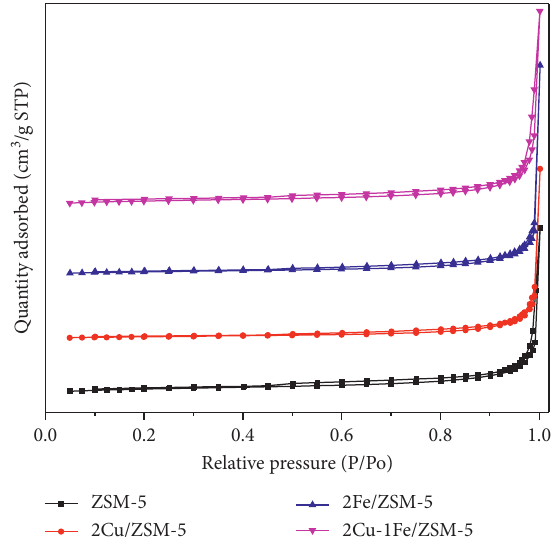
Figure 4: N 2 adsorption and desorption isotherms of